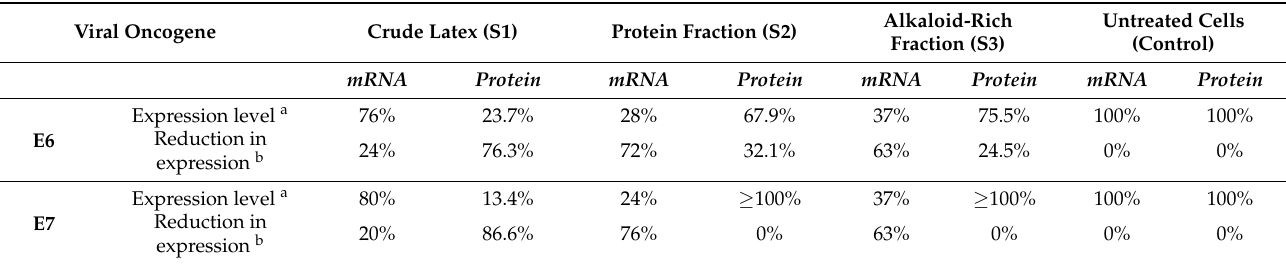
Table 3. Comparison of the expression of E6 and E7 viral oncogenes at the mRNA and protein levels after treatment of HeLa cells with crude latex (S1) and its fractions (S2, S3). The table shows the percentage values for the expression level and the reduction in gene expression level compared to control (untreated cells). Both values add up to 100%.